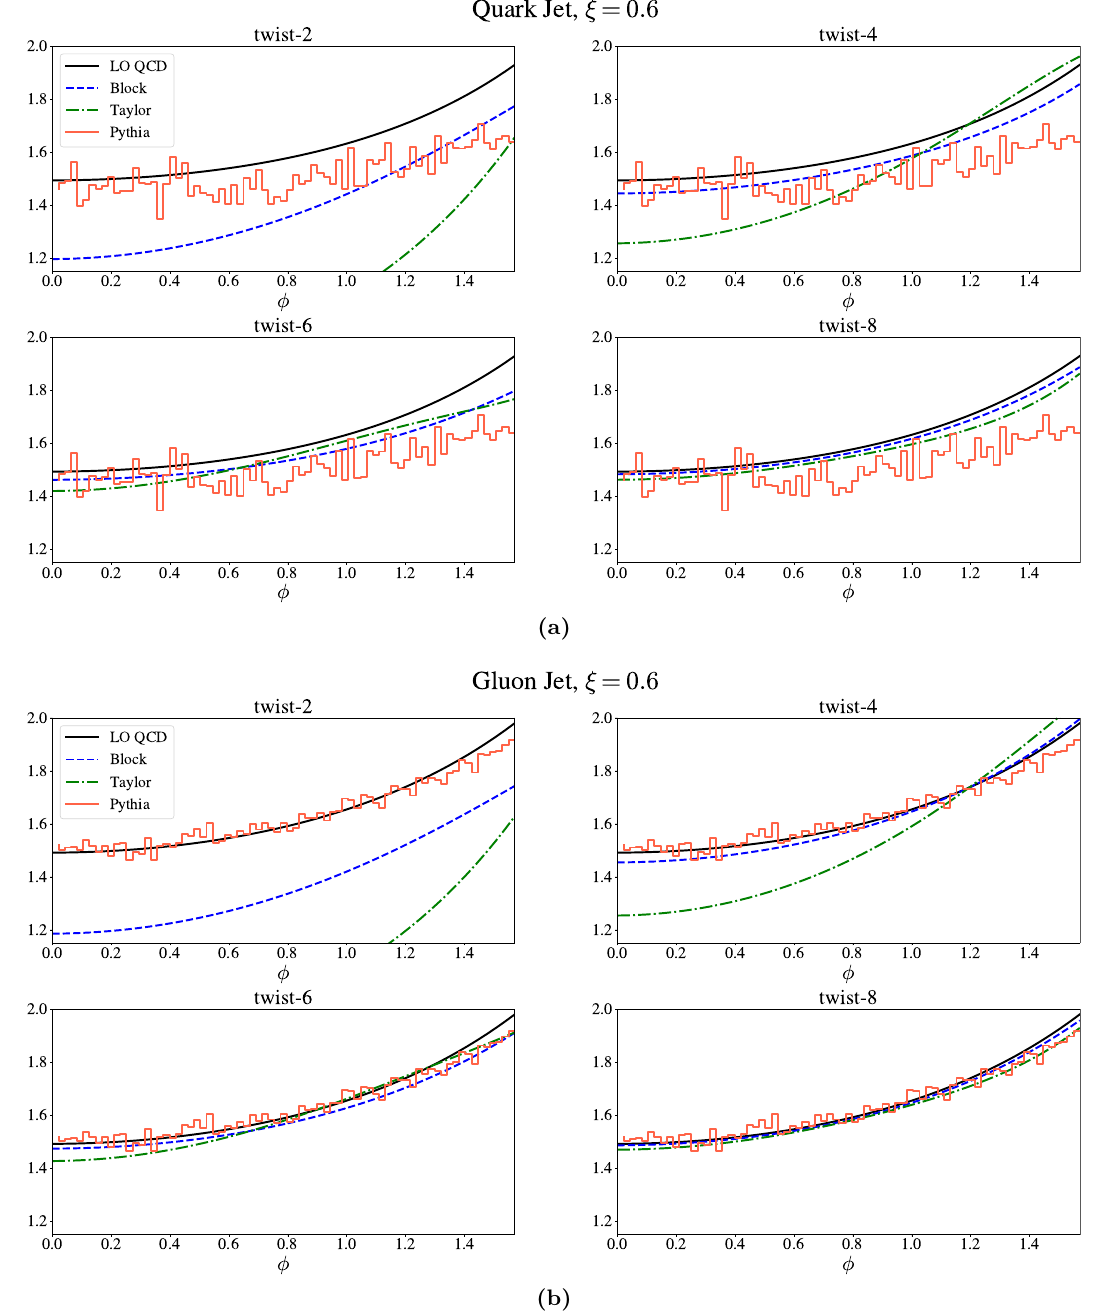
Figure 14. A slice of the leading order three-point correlator at ξ = 0 . 6 for quark jets in (a) and gluon jets in (b). We compare the full QCD result, the expansion in celestial blocks, the naive Taylor expansion, and the result from Pythia. The expansion in celestial blocks converges